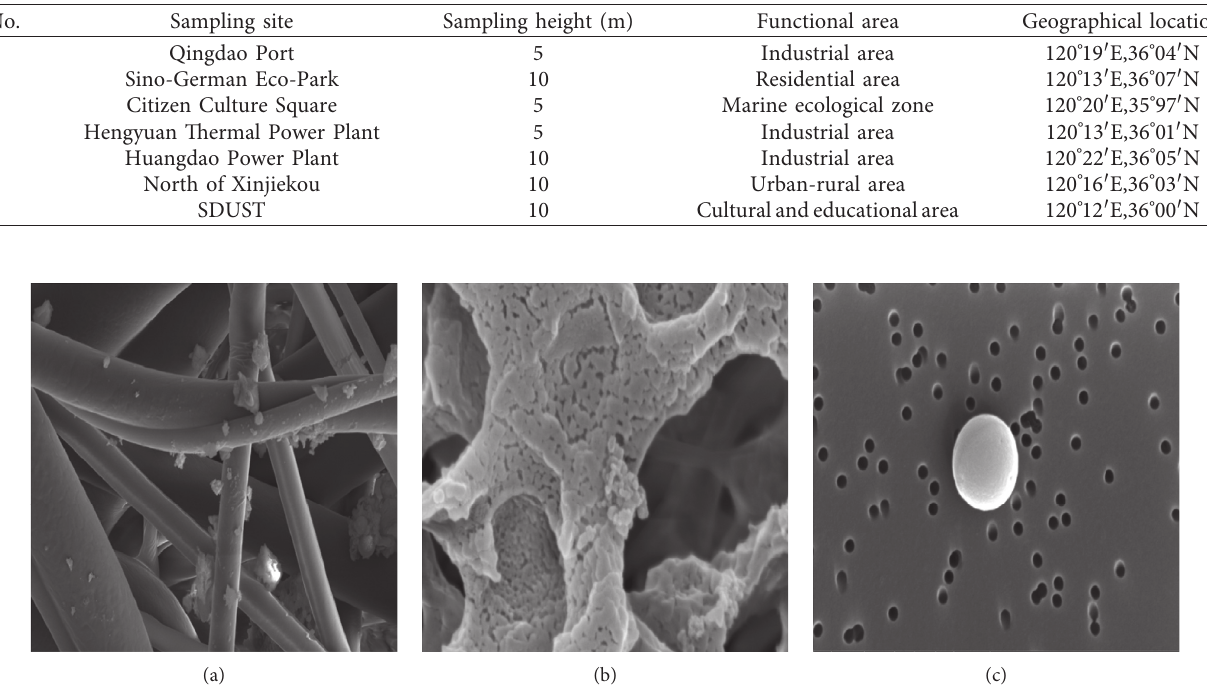
Table 1: Information of sampling sites.